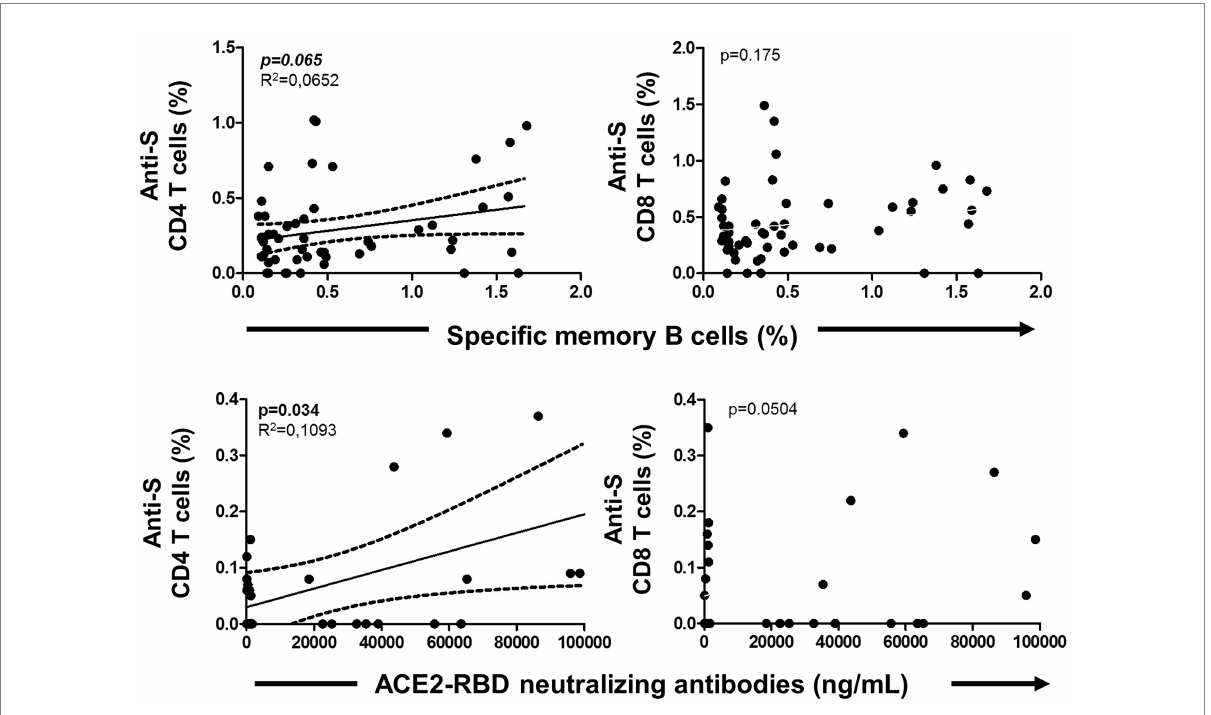
FIGURE 6 Association of specific memory B cells with anti-S CD4 and CD8 T cells (upper side) and ACE2-RBD neutralizing antibodies with anti-S CD4 and CD8 T cells (lower side) after vaccination. Pearson’s correlation r value and two-tailed p values are shown only with statistical significance ( p <